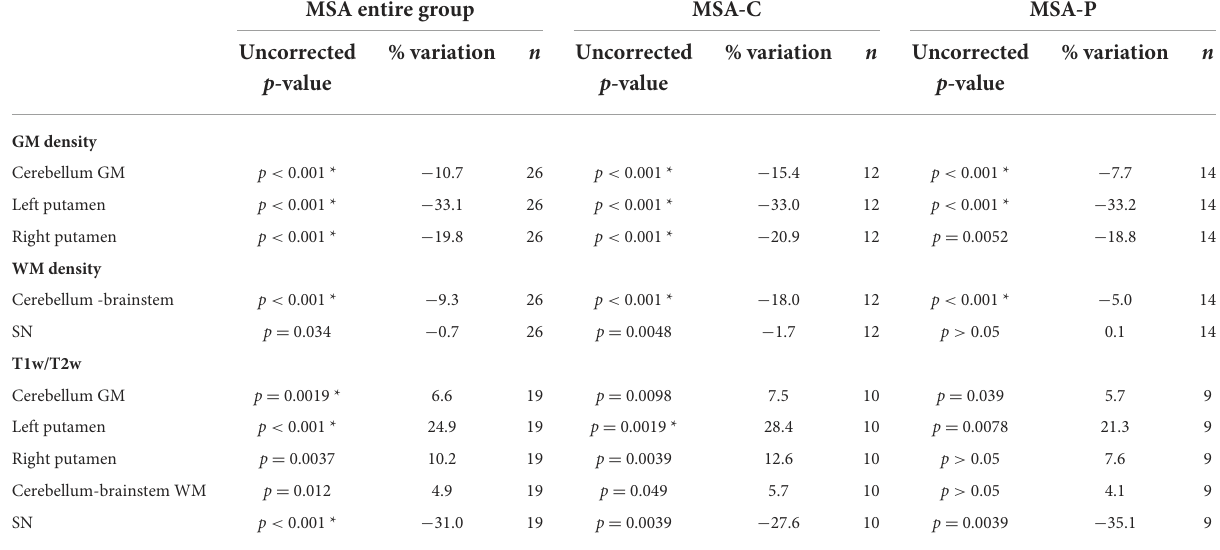
TABLE 2 Results of regional longitudinal